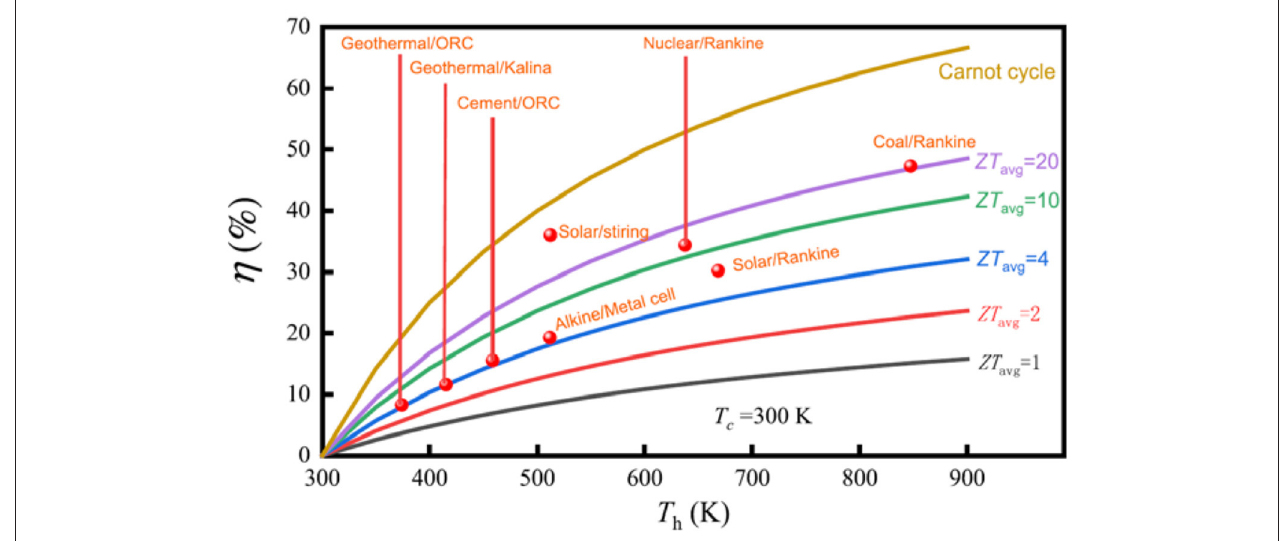
FIGURE 2 | TE energy conversion efficiency ( η ) vs. hot-side temperature (Th) for different ZT avg values. Reprint with permission from Yu et al. (2019).